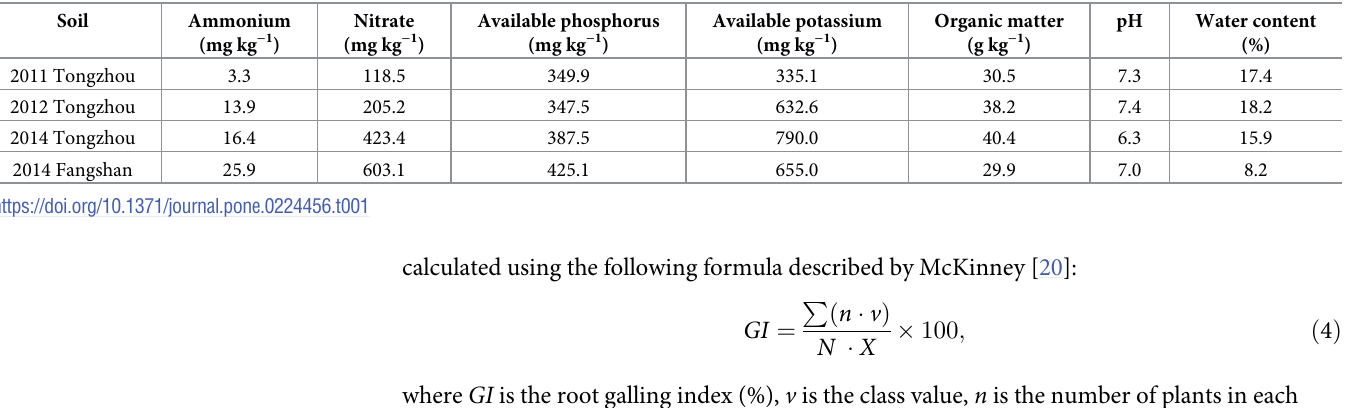
Table 1. Basic physical and chemical properties of the experimental soil.